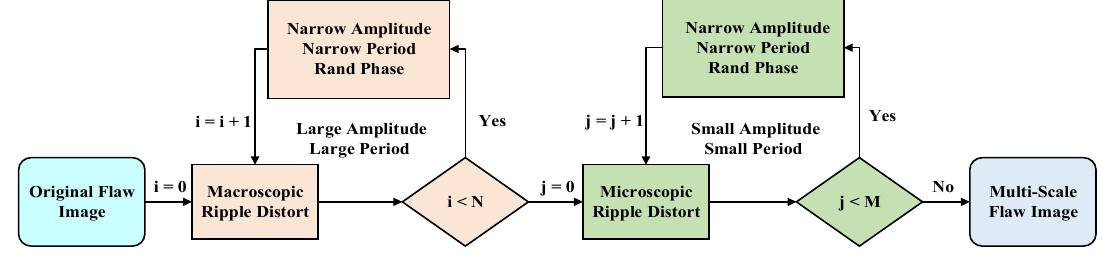
Figure 2. Flowchart of multi-scale distortion.